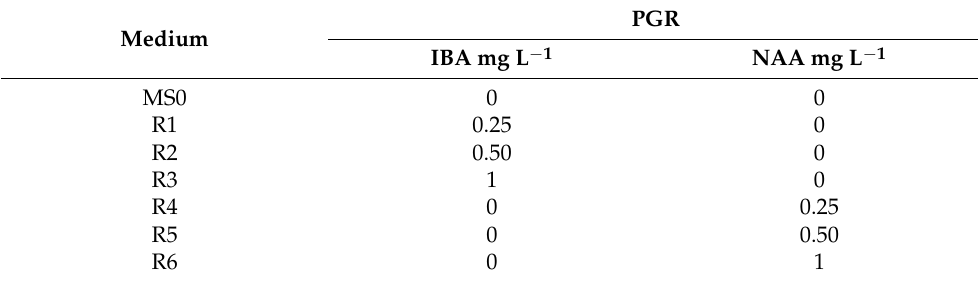
Abbreviations: MS0 (control, hormone-free, medium with sucrose); R1, R2, R3, (medium with different concentra- tions of IBA, 0.25 mg L − 1 , 0.50 mg L − 1 , 1 mg L − 1 , respectively); R4, R5, R6 (medium with different